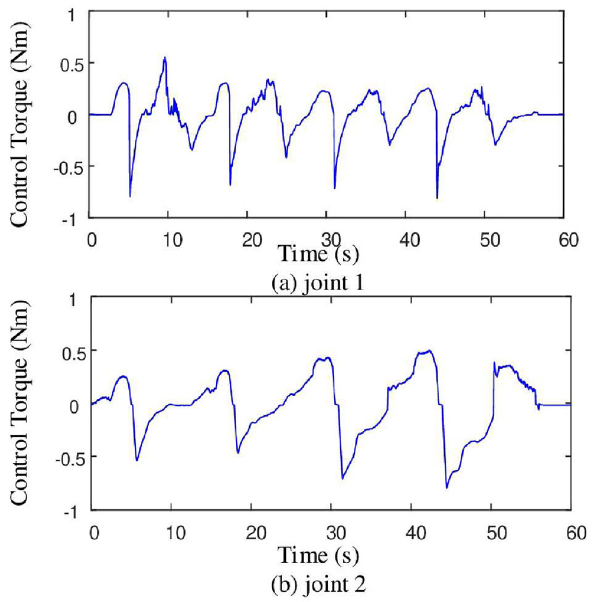
Fig. 14 Control torque curves under existing integral sliding mode control method the proposed decentralized robust interaction control method not only converges within the acceptable threshold range, but also has no obvious chattering effect. Since these exist- ing two control methods only control the trajectory tracking, the human–robot interaction contact force curve of the exist- ing decentralized robust control method is far beyond the safe range. In addition, the proposed decentralized